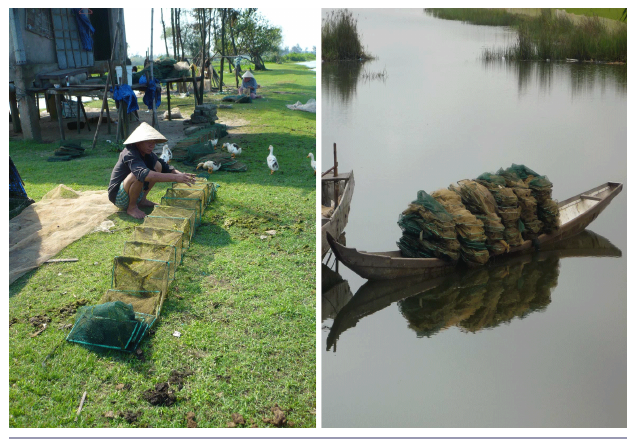
Fig. 5 . Steel-framed bottom